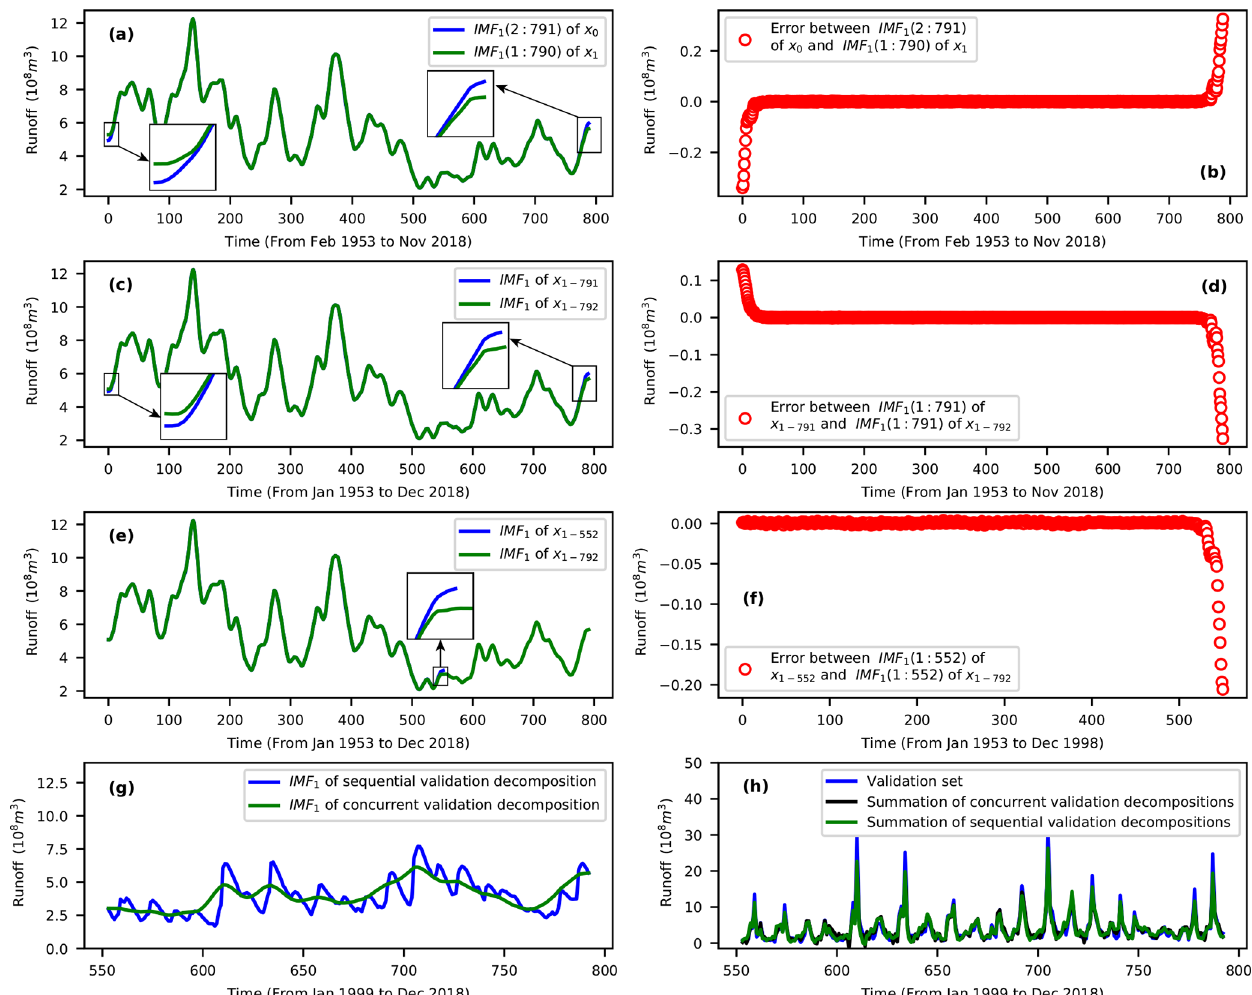
Figure 3. Examples of the boundary effects for the VMD method on monthly runoff data at the Huaxian station: (a, b) shift variance, (c, d) sensitivity to appending one data point, (e, f) sensitivity to appending several data points, (g) differences between sequential and concurrent validation-data decompositions, and (h) differences between the summation of the sequential and concurrent validation-data